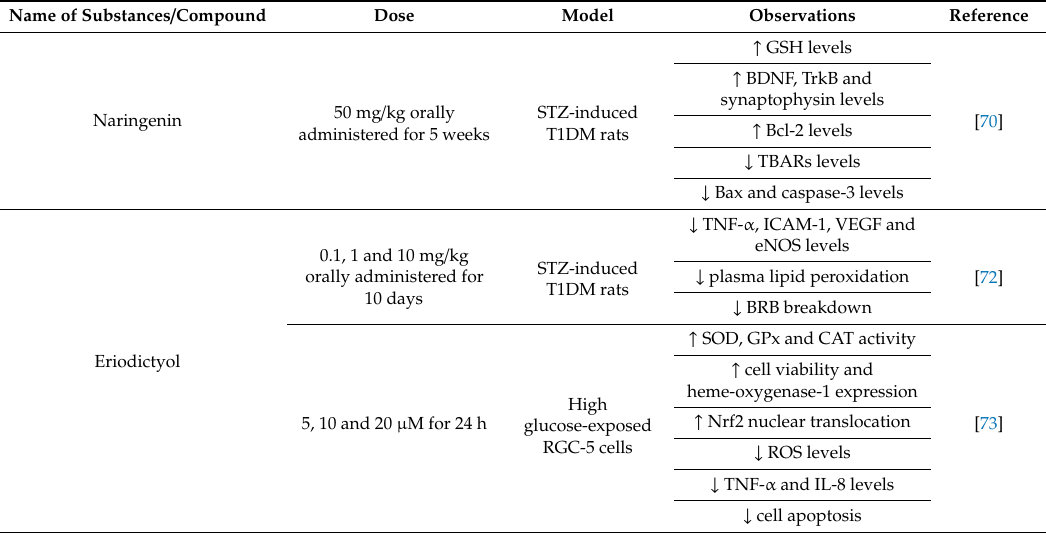
Table 3. E ff ects of flavanones on cellular and molecular mechanisms a ff ected by diabetic